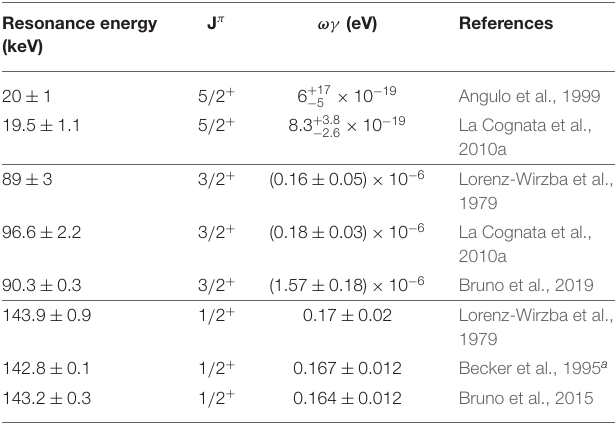
TABLE 4 | Summary table of the strengths of the low-energy resonances in the 18 O( p , α ) 15 N astrophysical factor. Resonance energy (keV)